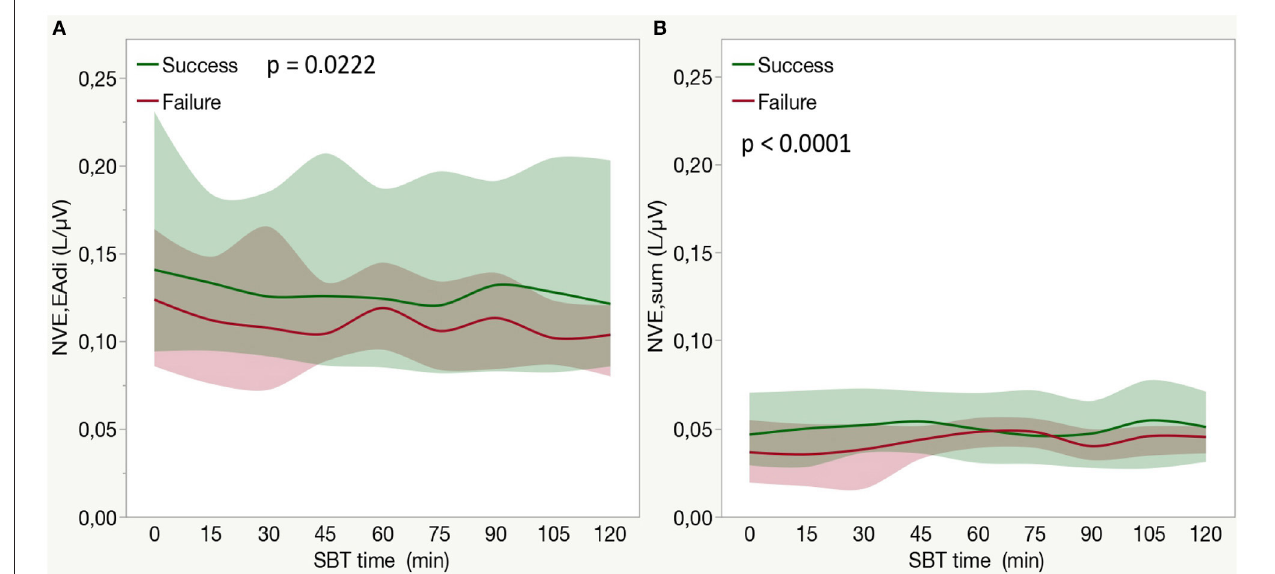
FIGURE 4 | (A) Neuroventilatory efficiency for diaphragm surface electrical activity (NVE EAdi ) in patients who fail or success weaning attempts among the entire duration of a SBT. Each line indicates the median value with bands indicating IQR. The P -value is for the between-group comparison performed with the use of the two-factor analysis of variance to test time (from 0 to 120min of SBT with the exclusion of baseline step) and group effects (SBT failure or success). In a post-hoc analysis median NVE EAdi at each time point (from 0 to 120min) was not different from baseline ( p > 0.05) both in the success and failure group. (B) Neuroventilatory efficiency for sum of inspiratory muscles surface electrical activity (NVE sum ) in patients who fail or succeed weaning attempt during the entire duration of a SBT. Each bar indicates the median value with bands indicating IQR. The P -value is for the between-group comparison performed with the use of the two-factor analysis of variance to test time (from 0 to 120min of SBT with the exclusion of baseline step) and group effects (SBT failure or success). In a post-hoc analysis comparing median NVE sum at each time point with the beginning of SBT (0min) NVE sum was higher at 30min ( p < 0.0001), 45min ( p < 0.0001), and 105min ( p = 0.0006) in the success group, while it was higher at 60min ( p = 0.005) but lower at 90min ( p < 0.0001). NVE EAdi , neuroventilatory efficiency for diaphragm surface electrical activity; NVE sum , neuroventilatory efficiency for sum of inspiratory muscles surface electrical activity; SBT, spontaneous breathing